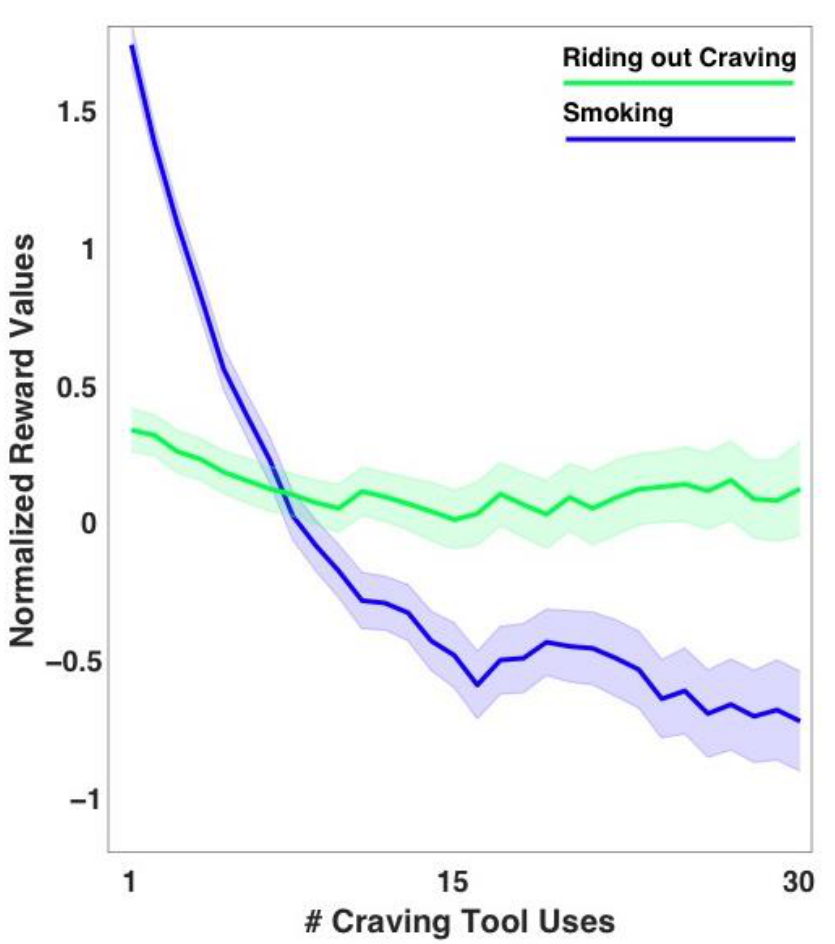
Figure 2. Normalized expected reward values by craving tool use (averaged across participants) for smoking and not smoking by “riding out” their craving with a brief informal mindfulness practice (RAIN exercise). For display purposes, expected values were generated using group-averaged initial values for each action as V0.